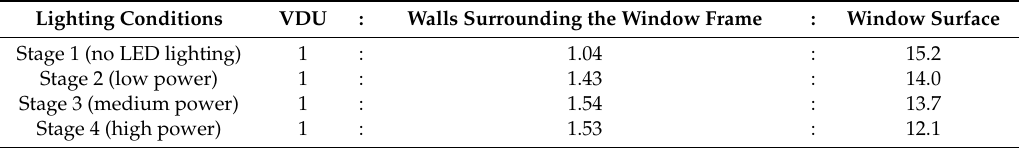
Table 3. Average median luminance contrast of the visual display unit (VDU) and the walls surrounding the window frame, as well as the luminance contrast of the VDU and the window